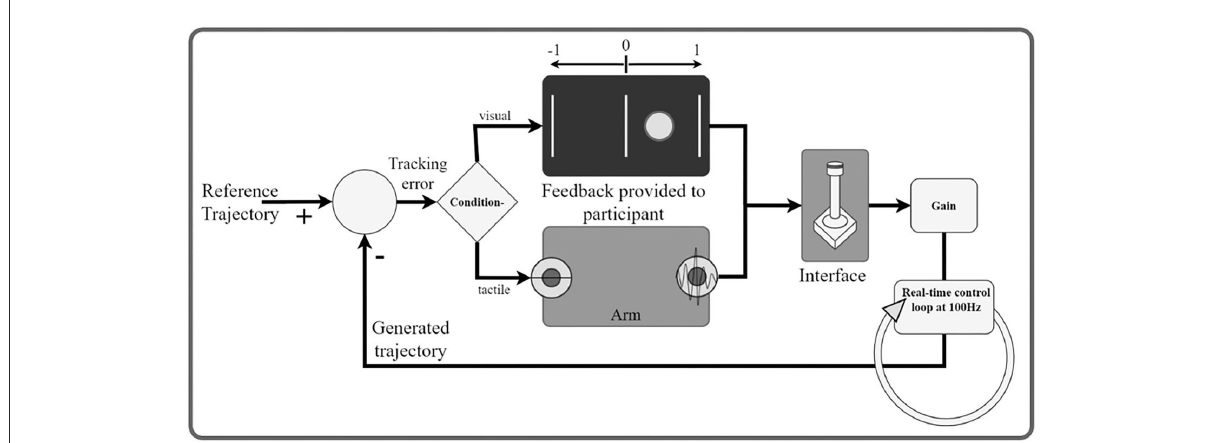
FIGURE3 Schematic illustration of the real-time control loop. The participant (human operator) is a part of a dynamic system. The goal is to generate a signal with the joystick that minimizes the tracking error with respect to a predefined reference trajectory. The tracking error is communicated to the participant through tactile/visual feedback. In the visual feedback, the onscreen circle communicates the sign and the magnitude of the error. In the tactile conditions, the active stimulator codes for the sign and the amplitude for the magnitude of the error.